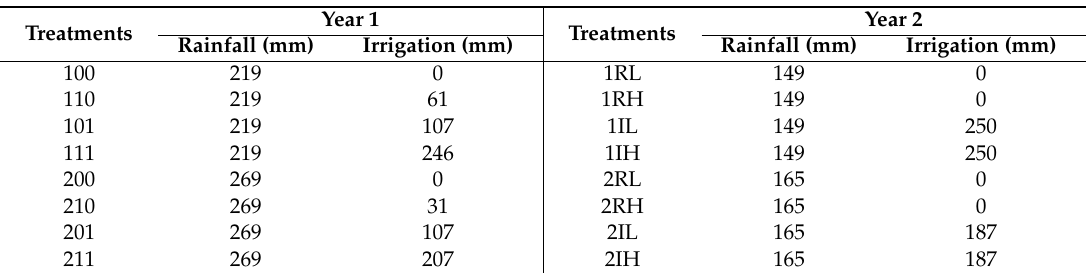
Figure 2. Rain, irrigation, evapotranspiration, and total soil water for the calibration treatment in 2017. Table 2. Rainfall and irrigation data for the di ff erent treatments in the first and second years of the field experiment.